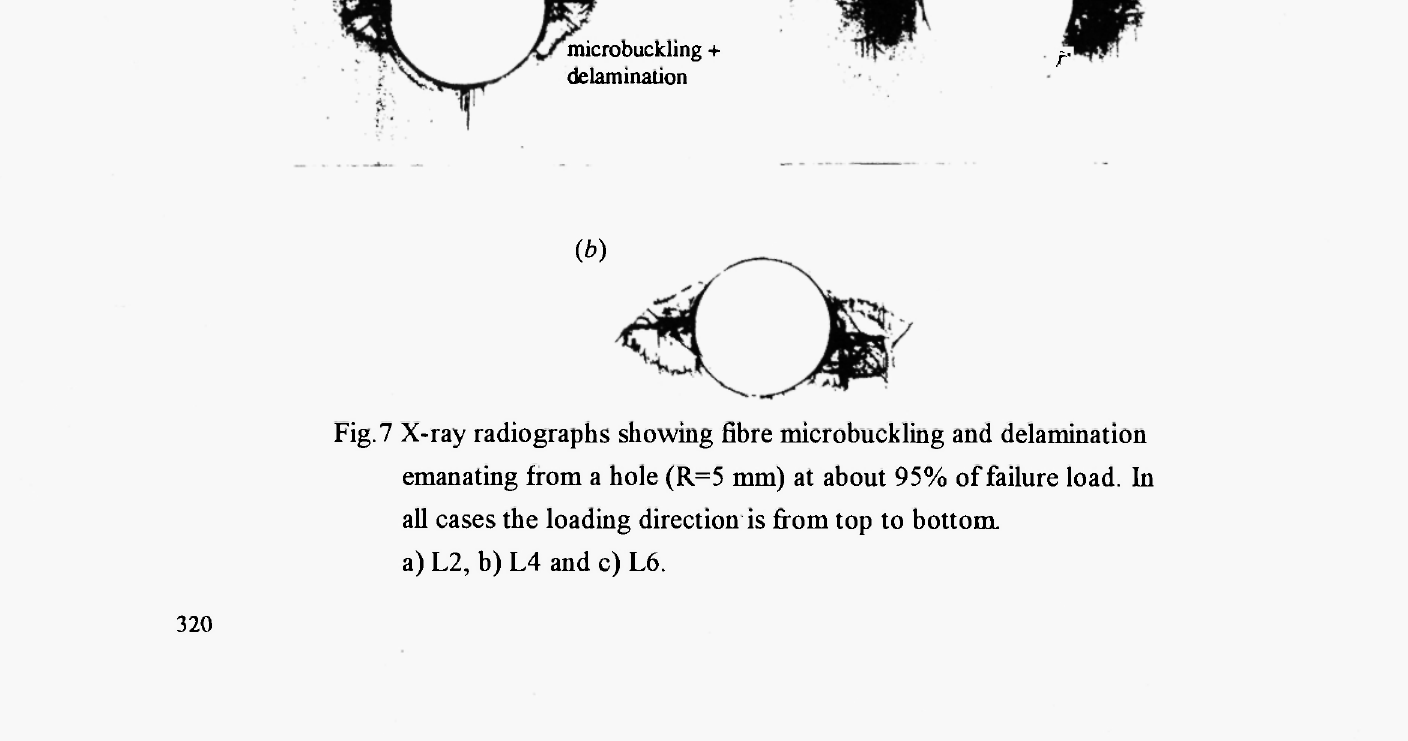
Fig.7 X-ray radiographs showing fibre microbuckling and delamination emanating from a hole (R=5 mm) at about 95% of failure load. In all cases the loading direction is from top to bottom a) L2, b) L4 and c)